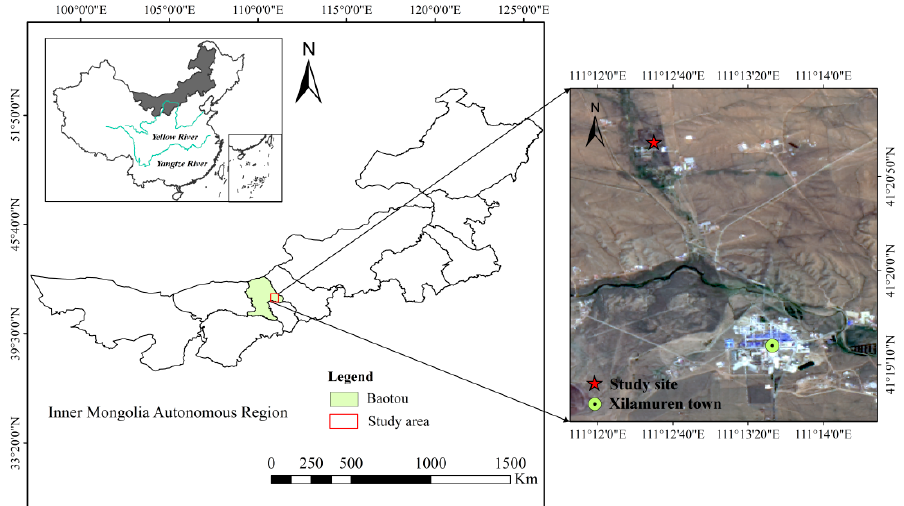
Figure 1. Location of the study site.